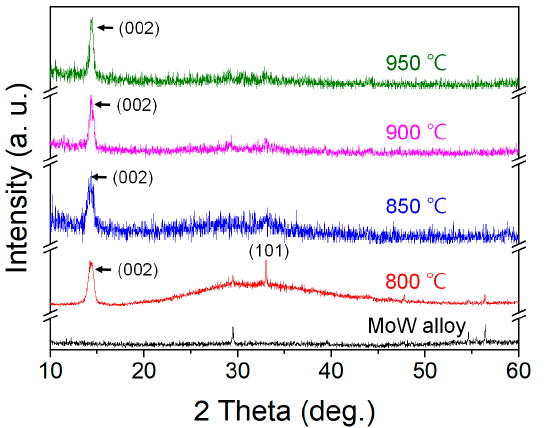
Figure 3. XRD 2 θ scan results of the Mo x W 1 − x S 2 thin films sulfurized at various temperatures.